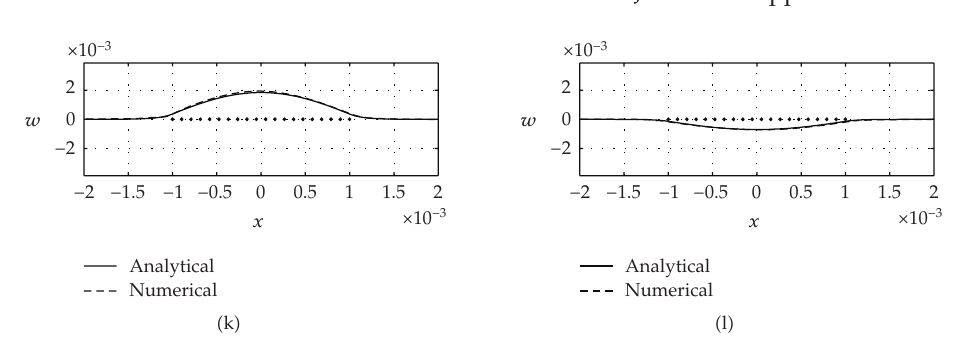
Figure 2: FHN bifurcation solution. comparison of analytical and numerical approximations. Snapshots of the solutions at six di ff erent times; the analytical solution has been shifted in time to be in phase with the numerical solution. The dots indicate the automatic domain on (cid:6) − 0 . 001 , 0 . 001 (cid:7) .